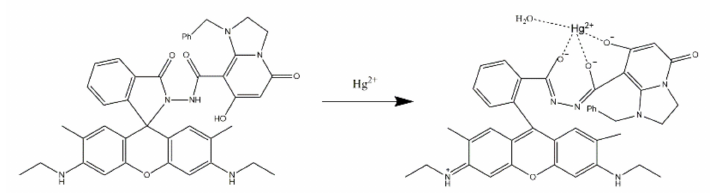
and sensitive response for Hg 2+ (Table 1, No. 9) [41]. The UV-Vis and fluorescence spectral profiles changed in the presence of Hg 2+ due to the formation of the coordinate bond between RhB and Hg 2+ (Figure 8). The detection limit was around 2.57 × 10 − 6 M and the prepared sensor detected Hg 2+ in 100% aqueous solution by the naked eye.